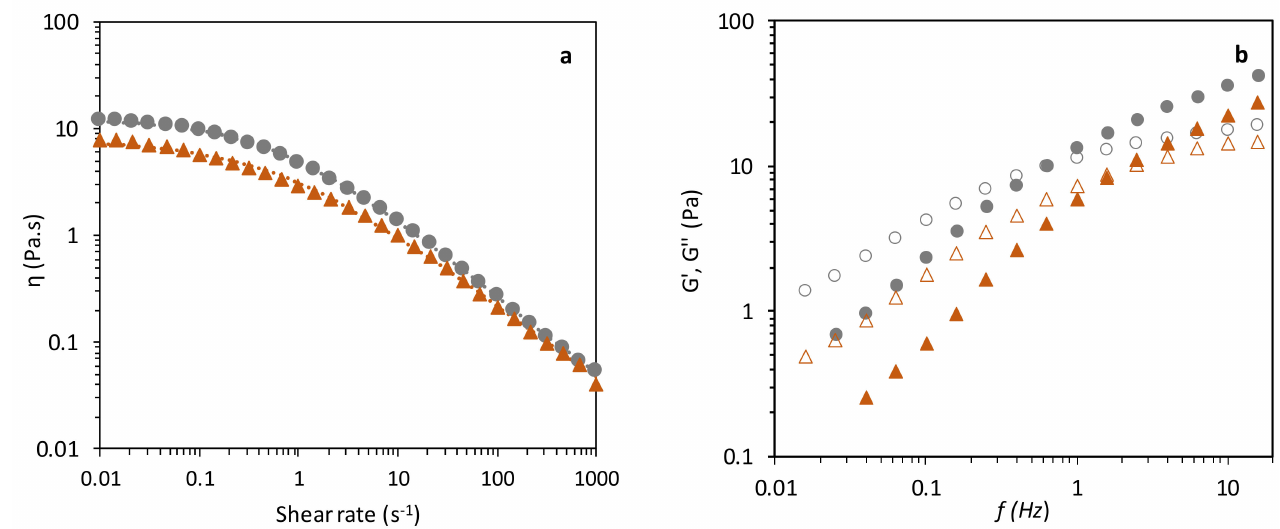
Figure 7. Rheological profile analysis of FucoPol formulations F1 (circles) and F2 (triangles): ( a ) vis- cosity curves as a function of the shear rate, flow curves fitted with Cross model ( n = 3); ( b ) elastic G’ (closed) and viscous G” (open) moduli in the function of frequency.